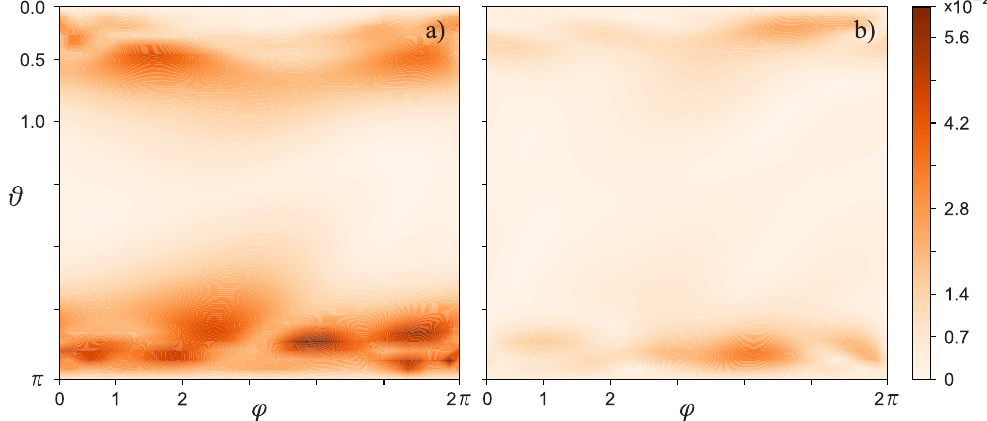
Figure 6. The normalized value of the magnitude of the retrieved magnetic mass carrier density M ( ρ cos ϕ sin θ , ρ sin ϕ sin θ , ρ cos θ ) . The calculations were carried out for data localized in the